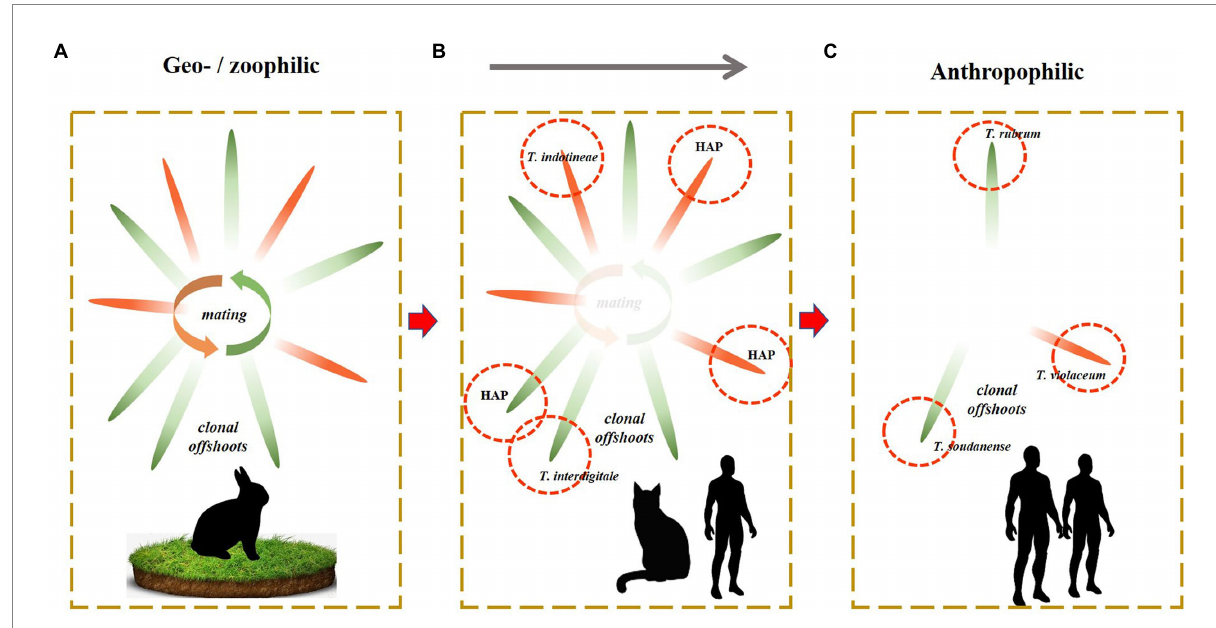
FIGURE 3 Sexuality with clonal offshoots in terrestrial species (A) . Gradual loss of sexuality with longer transmission periods of clonal offshoots in zoophilic species (B) . Complete loss of sexuality with specialization of some clones surviving on the human host (C)